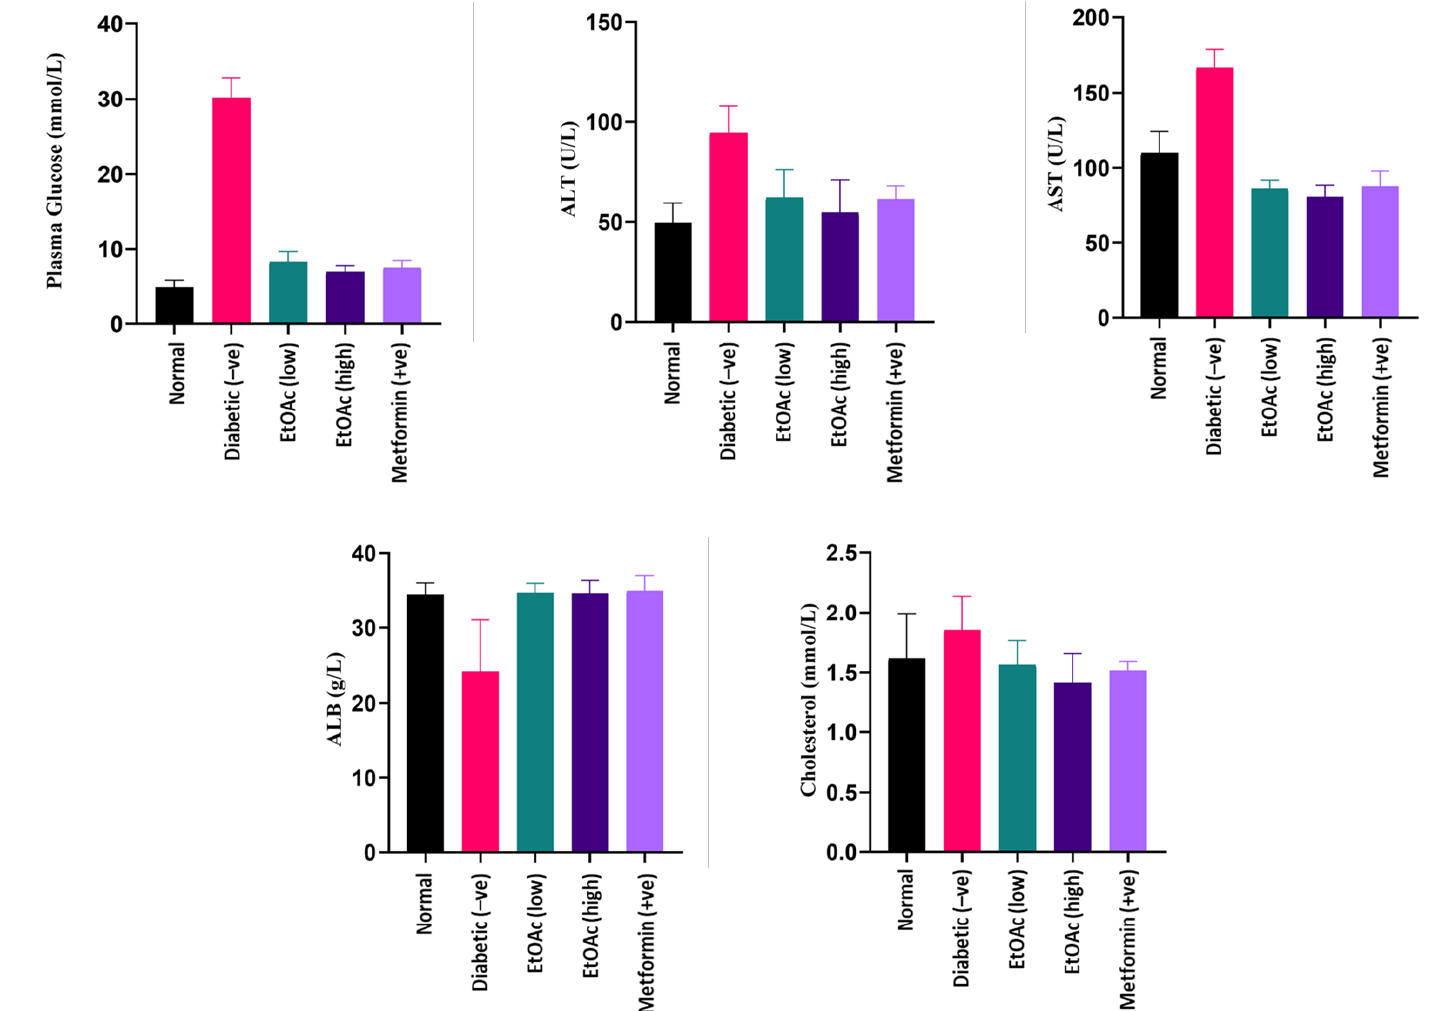
Figure 3. Plasma glucose, ALT, AST, albumin and cholesterol levels of diabetic rats treated with cultivated C. racemosa EtOAc